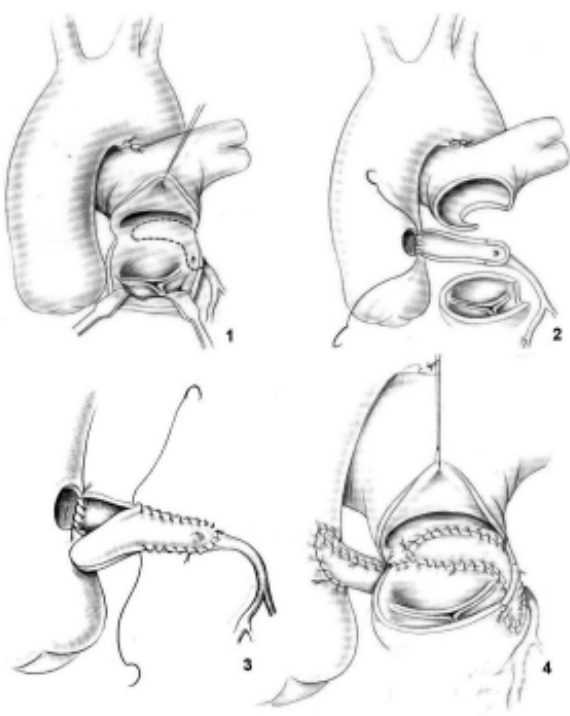
Fig. 1 - Representação esquemática do reimplante da coronária esquerda na aorta